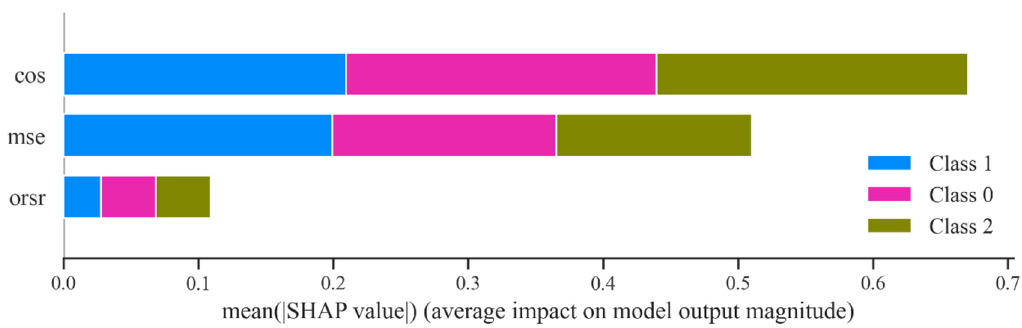
Figure 13. SHAP values of the AE-based features.